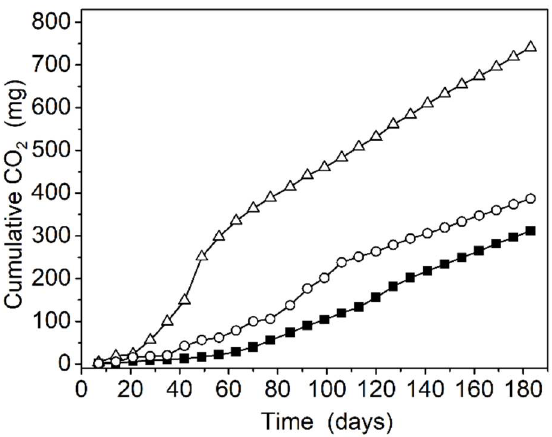
Figure 9. Average cumulative carbon dioxide production from TPS (full squares), TPS incorporated with rGO-g at 1.0 mass% (triangles) and 2.0 mass% (circles) contents for 183 days.